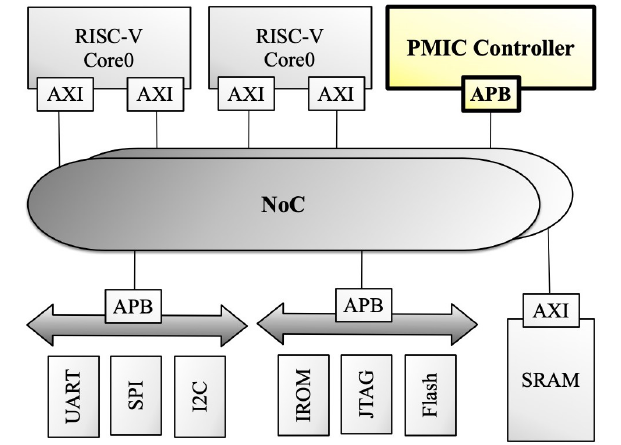
Figure 8. Architecture of the developed ULP-SoC.